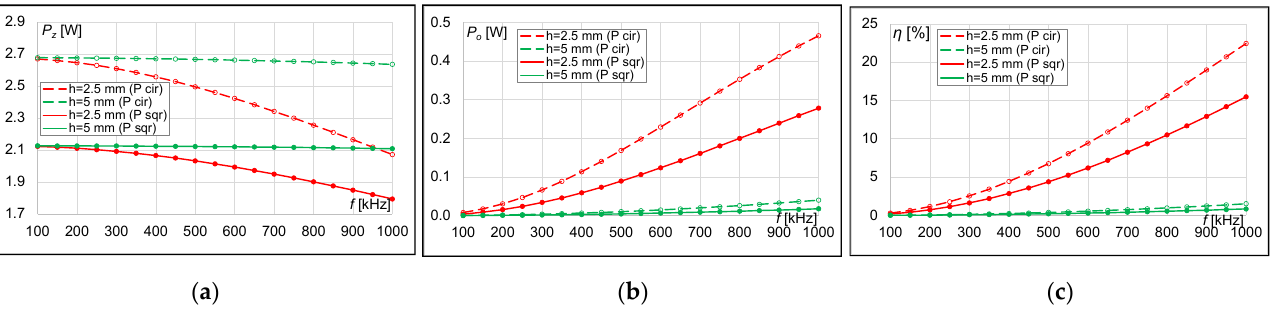
Figure 18. Results for the periodic system with circular or square coils with r = 5 mm and the number of turns n = 15 at two distances ( h = 2.5 mm and h = 5 mm): ( a ) transmitter power, ( b ) receiver power, ( c ) power transfer efficiency.